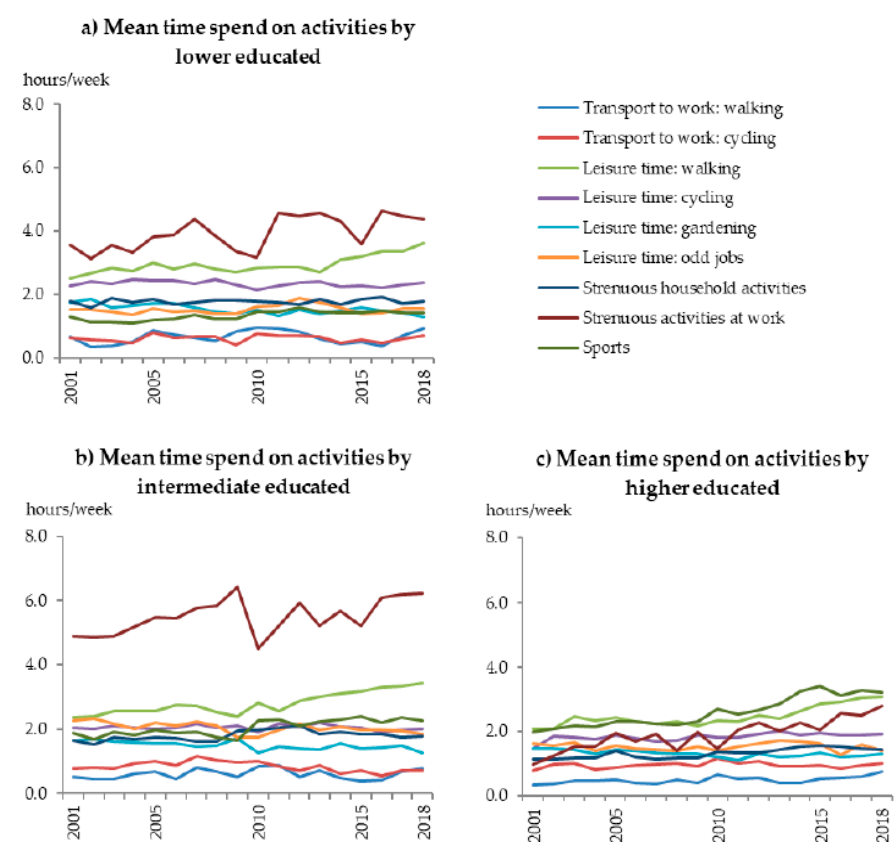
Figure 3. Mean time spend on activities at work or school, in household, during leisure time and sports per week for each year stratified for level of education, ( a ) lower educated (no, elementary, or low vocational/secondary schooling), ( b ) intermediate educated (intermediate vocational or intermediate/higher secondary schooling), ( c ) higher educated (higher vocational schooling